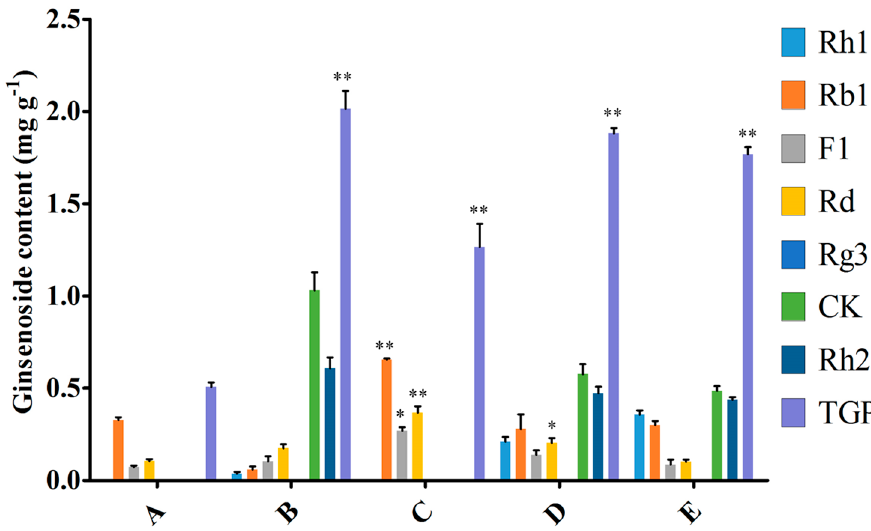
Figure 7. Effect of MeJA, endophytic bacteria and their combination on ginsenosides biosynthesis in flask culture. A, B, C, D, E represents the different addition method of endophytic bacteria and MeJA. A = without endophytic bacteria or MeJA treatment, B = 10.0 mL endophyte suspension, C = 100 µ M MeJA, D = 5.0 mL endophyte suspension + 50 μ M MeJA, and E =10.0 mL endophyte suspension + 100 µ M MeJA. TGP represents the total ginsenoside production. Data represent the mean ± standard deviation of three replicates. * Significantly different values between the treatment and control groups at p < 0.05. ** Very significantly different values between the treatment and control groups at p < 0.01.